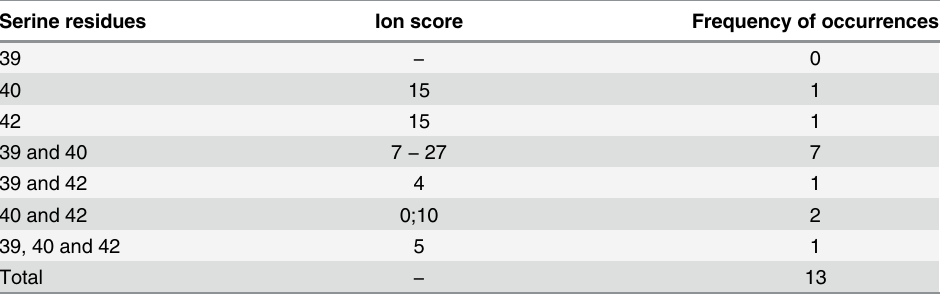
Table 1. Summary of the MASCOT search analysis on the 36 RRASSLSR 43 peptide stretch of CK β